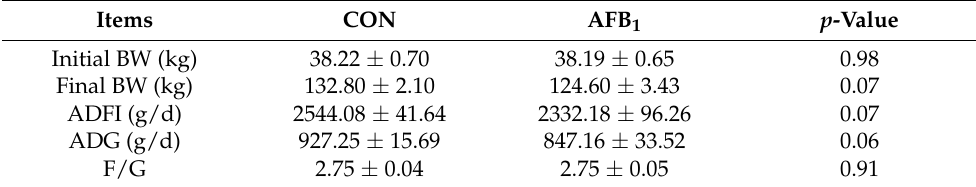
Table 5. Effects of AFB 1 on growth performance of